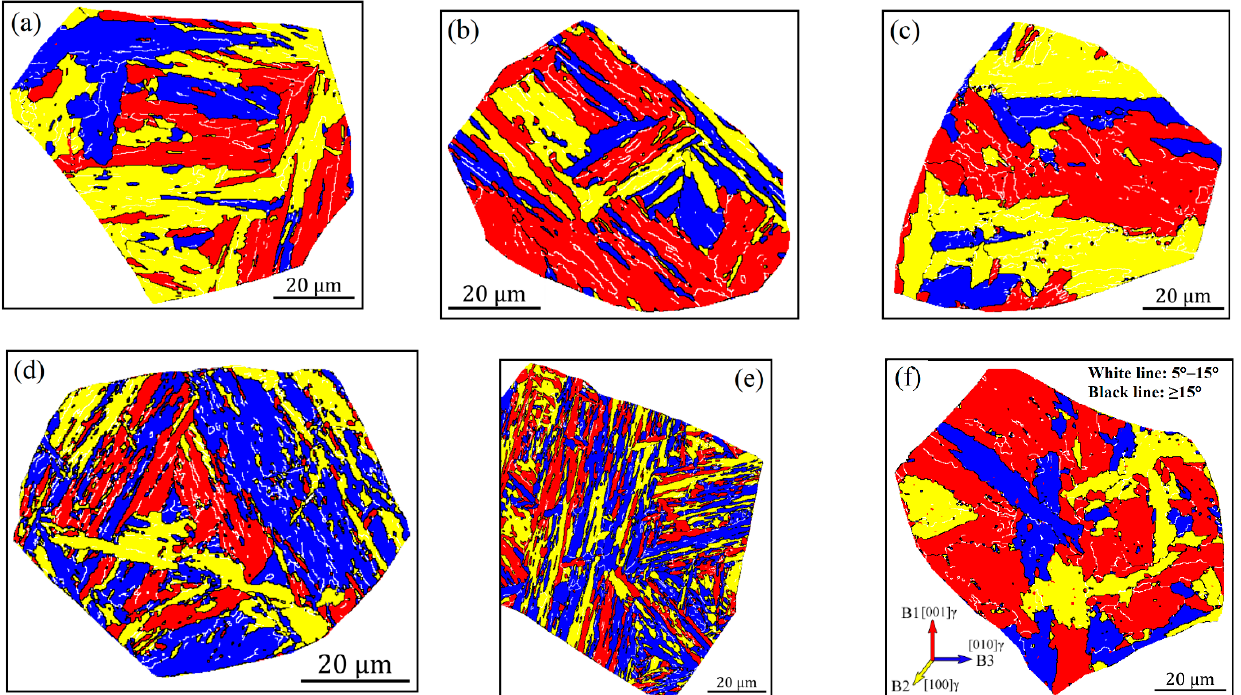
Figure 7. Reconstructed crystallographic Bain groups of the simulated samples with 0.04 wt.% C ( a – c ) and 0.12 wt.% C ( d – f ) under the different heat inputs: ( a , d ) 10 kJ/cm, ( b , e ) 20 kJ/cm and ( e , f ) 50 kJ/cm.